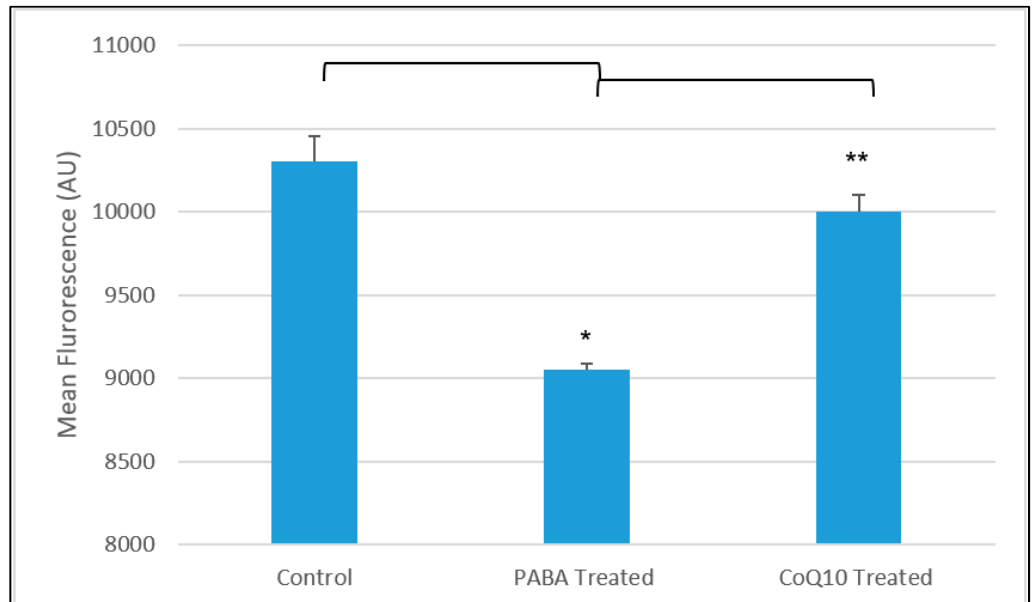
Figure 7. Mean fluorescence of control, PABA-treated cells and CoQ 10 (5 µ M) treated cells in the presence of PABA using data obtained in Figure 6. PABA-treated and CoQ 10 -treated (in the presence of PABA) cells following 3 days of incubation. Control and PABA-treated cells had been cultured for 5 days prior to this experiment as outlined in the cell culture section of the Material and Methods. Following incubation with CoQ 10, the LysoSensor (LS) fluorescence is significantly increased